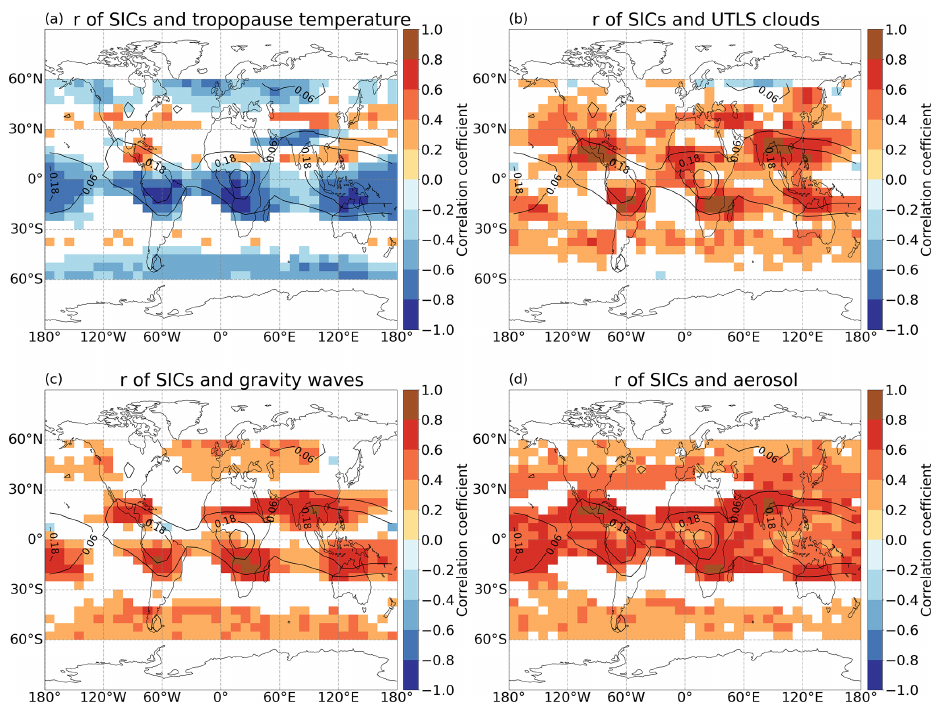
Figure 9. Spearman correlation coefficients of the SIC occurrence frequency and the first tropopause temperature, UTLS cloud event fre- quency, gravity waves, and stratospheric aerosol occurrence frequency from 2007 to 2019 with a grid cell in 5 ◦ latitude × 10 ◦ longitude. Only grid boxes with a SIC occurrence frequency > 0 . 02 and ≥ 80 data points in each grid box and at 99% significance level are presented. Occurrence frequencies of SICs are shown in black contours with an interval of 0.12.